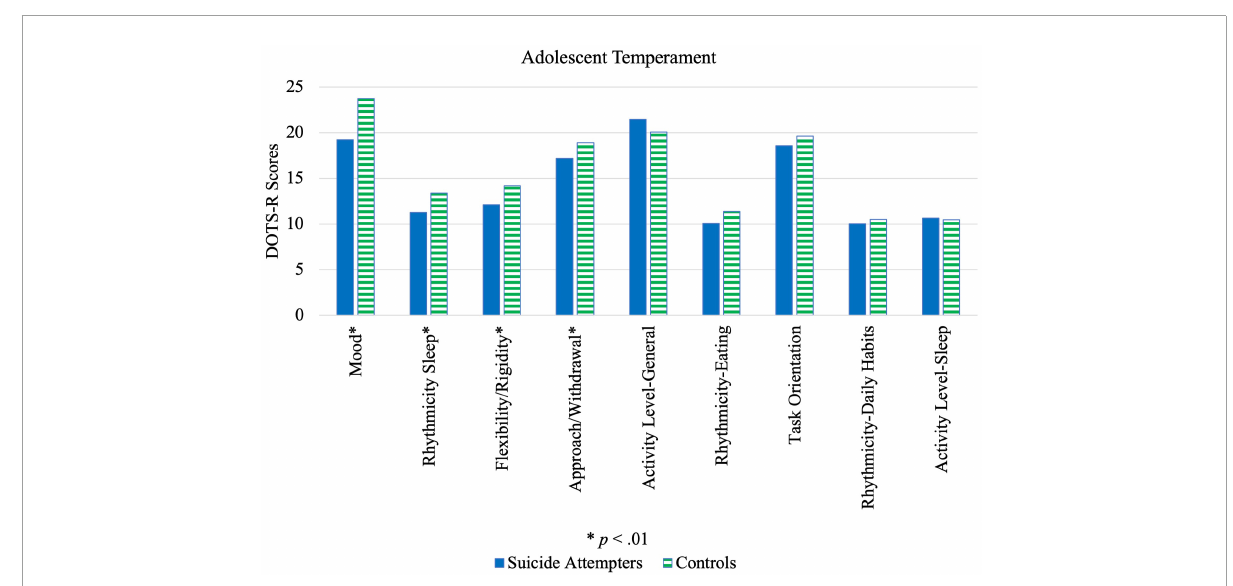
FIGURE2 Illustration of differences in temperament characteristics between suicide attempters and control group.